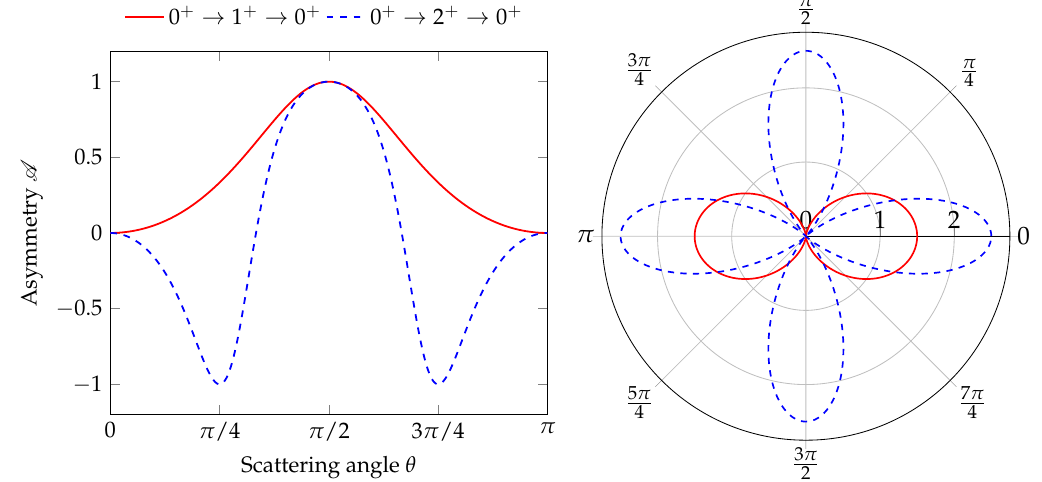
Figure 2. Ideal asymmetry ratios of magnetic dipole M 1 (solid line), and electric quadrupole E 2 (dashed line) transitions in even-even nuclei ( left ). Polar patterns of the dipole and quadrupole radiations ( right